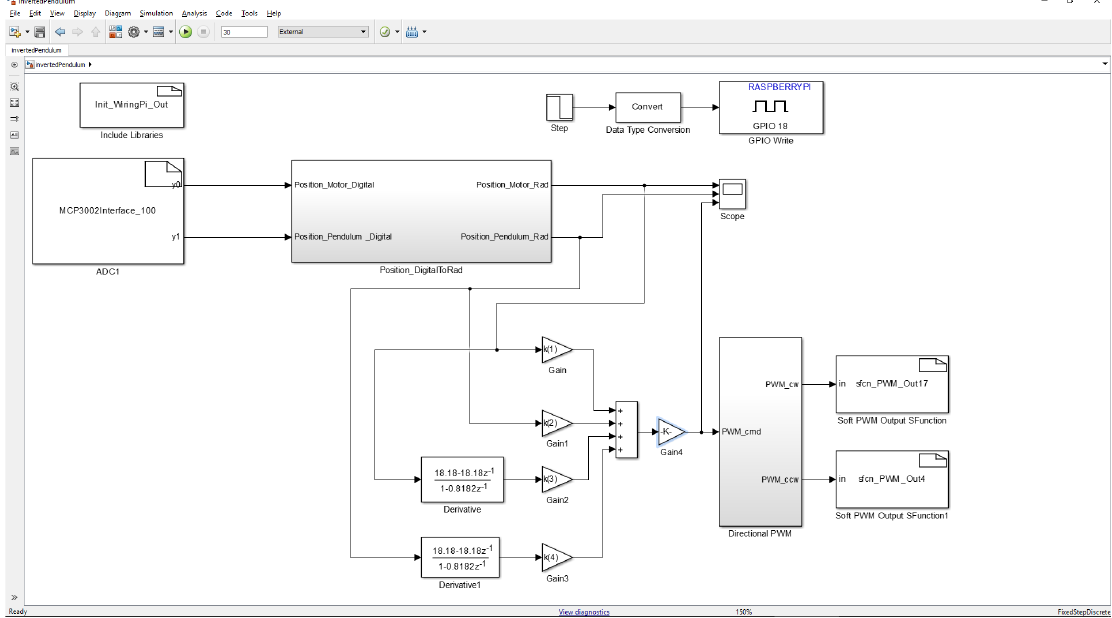
Figure 6. Complete Simulink model to control the Furuta Inverted